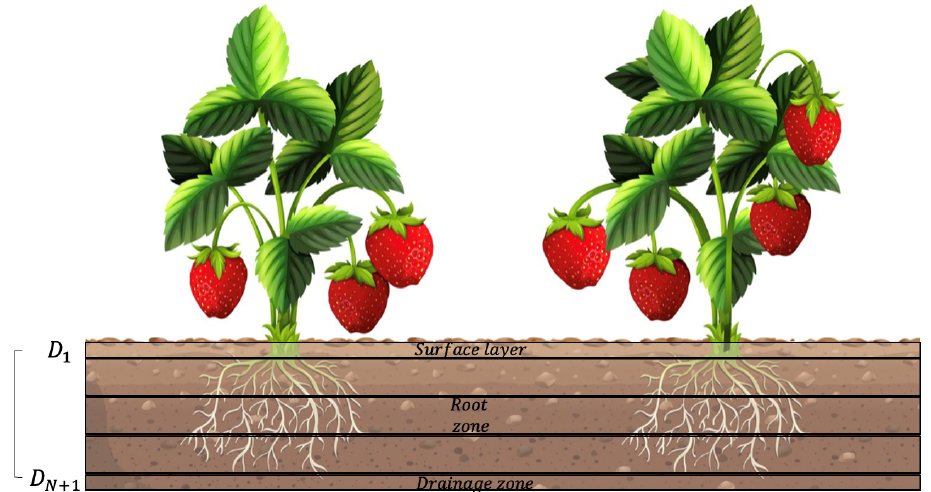
Figure 3. A schematic of the soil layer model with the proposed division into N + 1